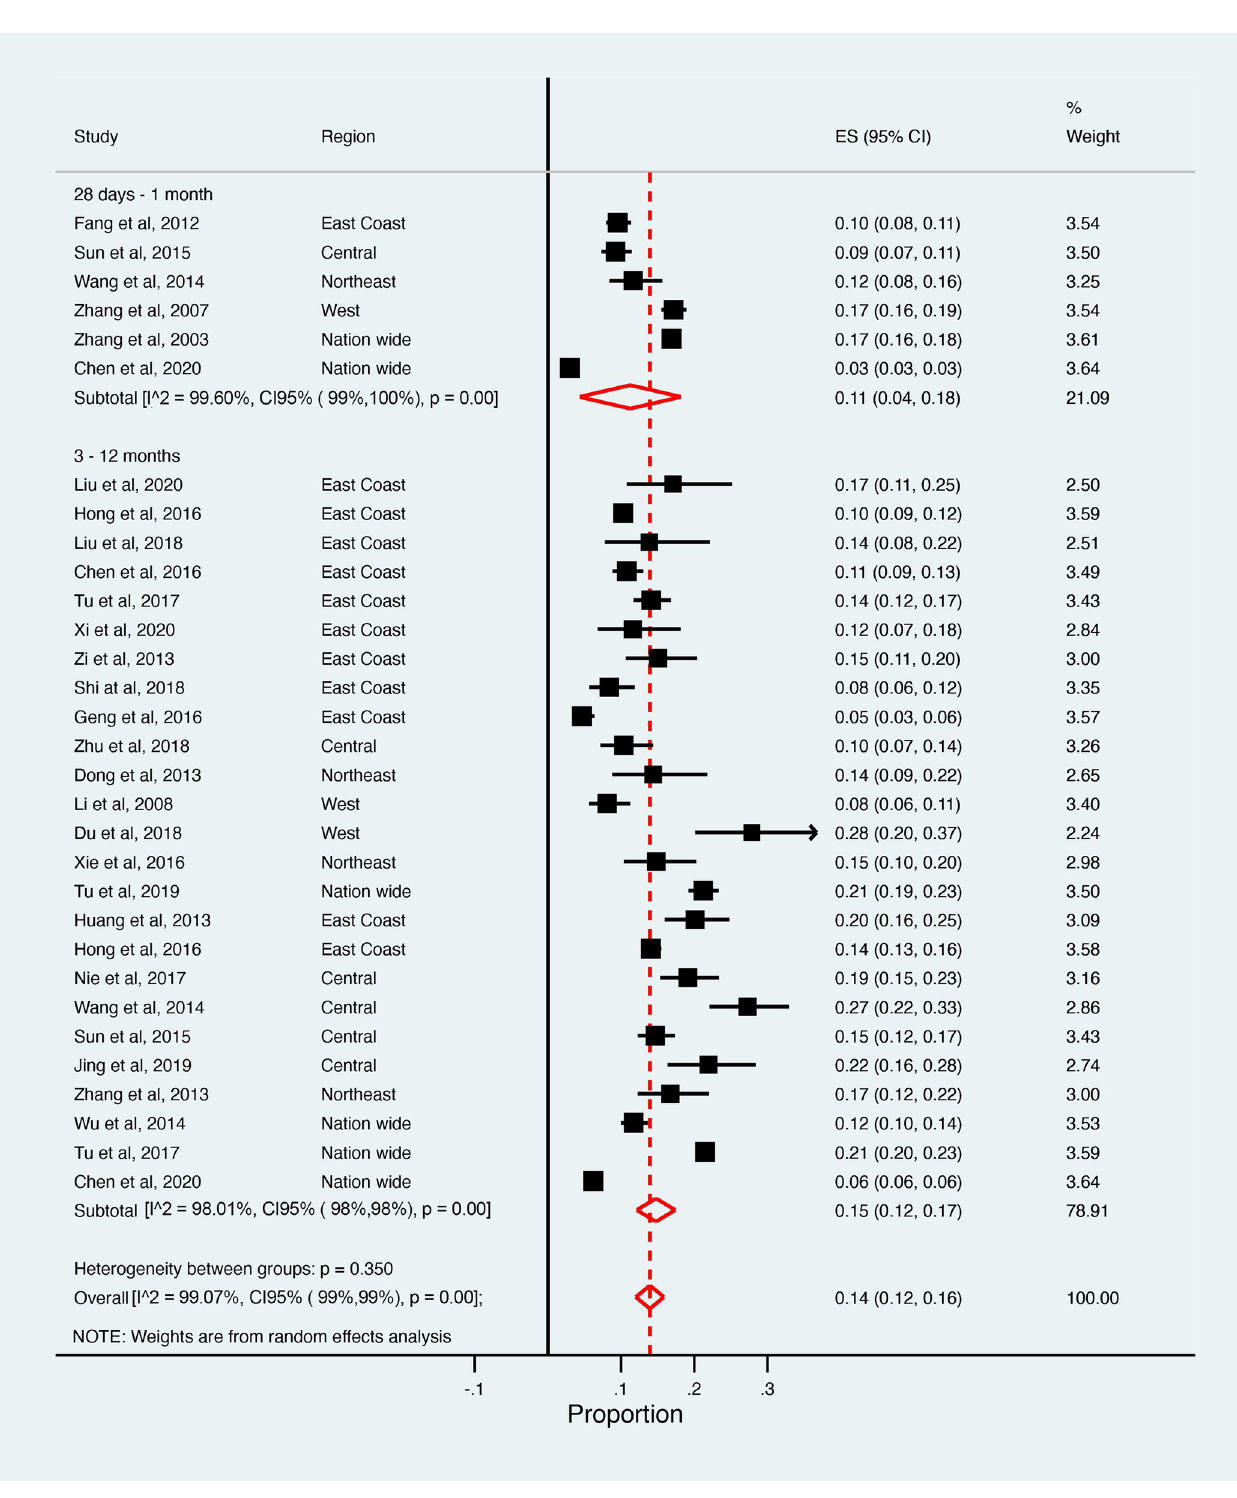
Fig 4. Pooled case-fatalities of ischaemic stroke.